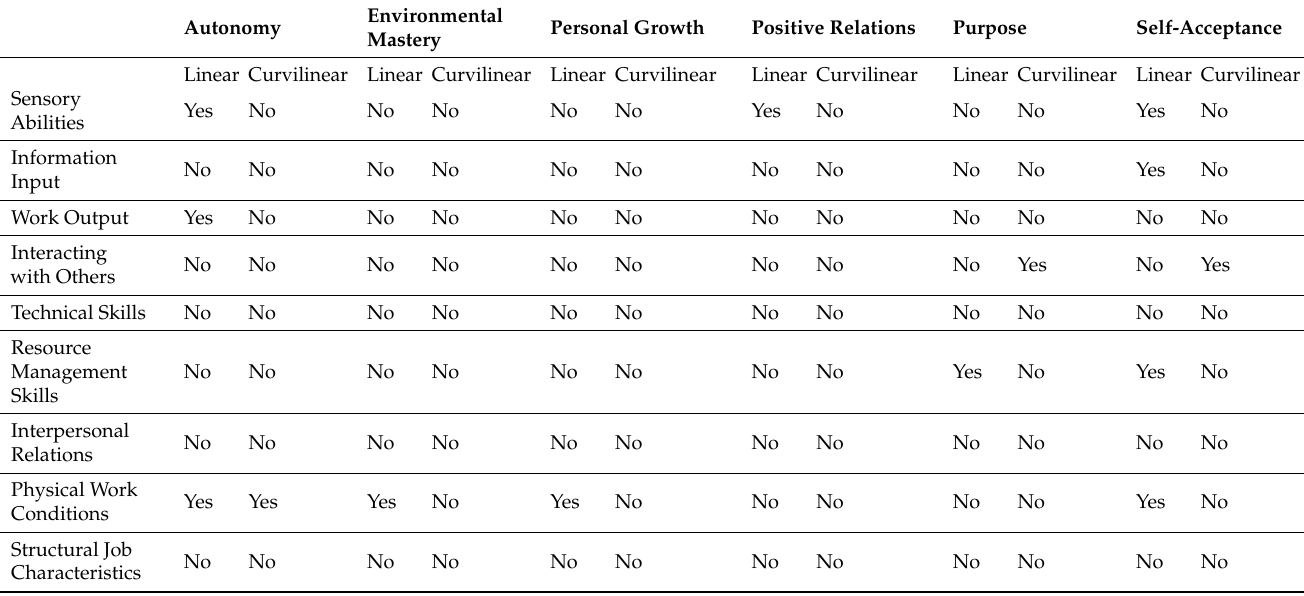
Table 3. Summary table indicating the linear and curvilinear associations for which race was a statistically signficant moderator of job characteristics and Ryff’s Six Dimensions of